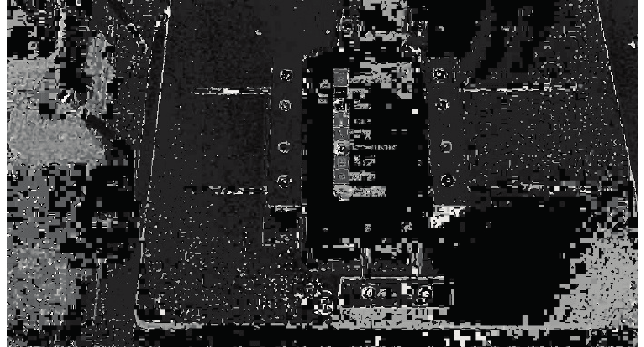
Figure 8. RGB image.